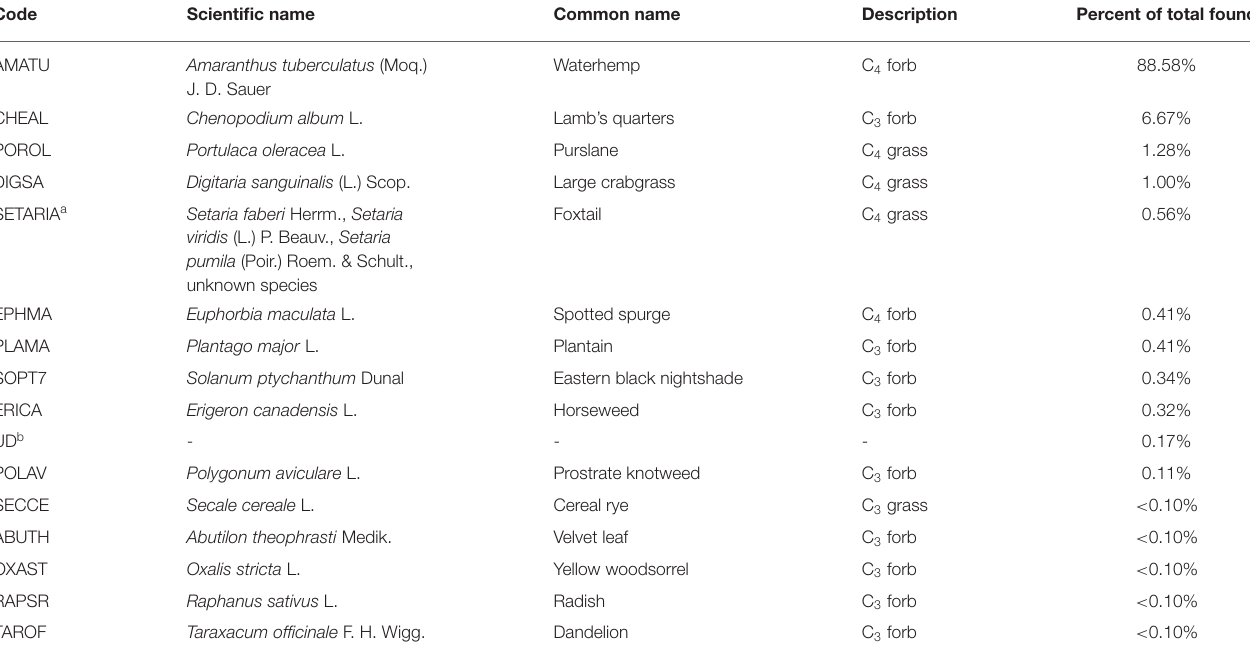
TABLE 3 | Summary of weed species identified in this study in order of prevalence.